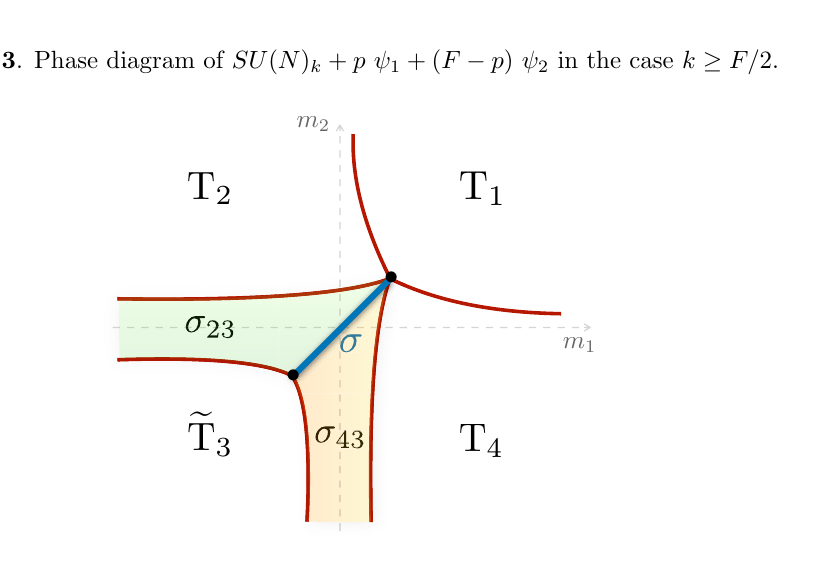
Figure 4 . Phase diagram of SU ( N ) k + p ψ 1 + ( F − p ) ψ 2 in the case F/ 2 − p ≤ k < F/